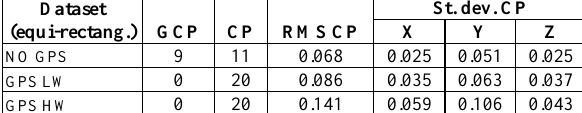
Table 13. Equirectangular dataset: stats on residuals [m].